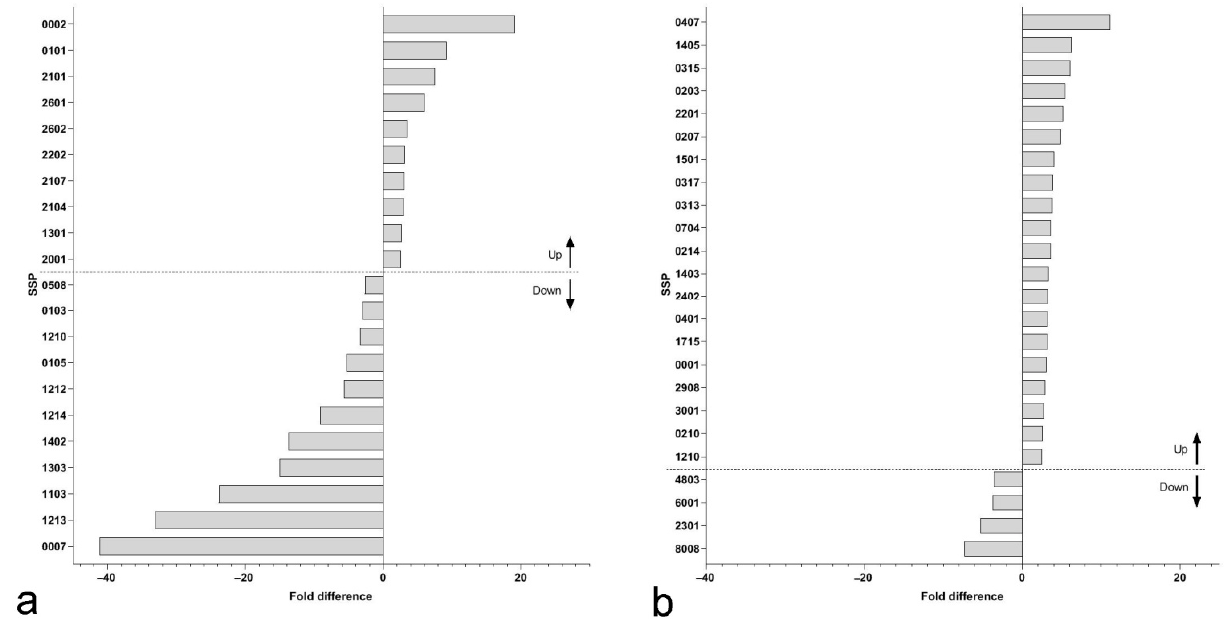
Figure 2. PDQuest master gel images of 2D-electrophoregrams of Arabidopsis leaves ( a ) and stem ( b ) and the respective differentially regulated protein spots ( c and d ). Arabidopsis was either par- asitized (p) or non-parasitized (np) by Cuscuta australis . Protein spot numbers correspond to the assigned by PDQuest.